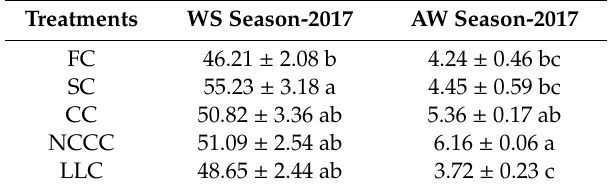
Table 3. E ff ect of di ff erent planting system on seasonal cucumber yield (kg /